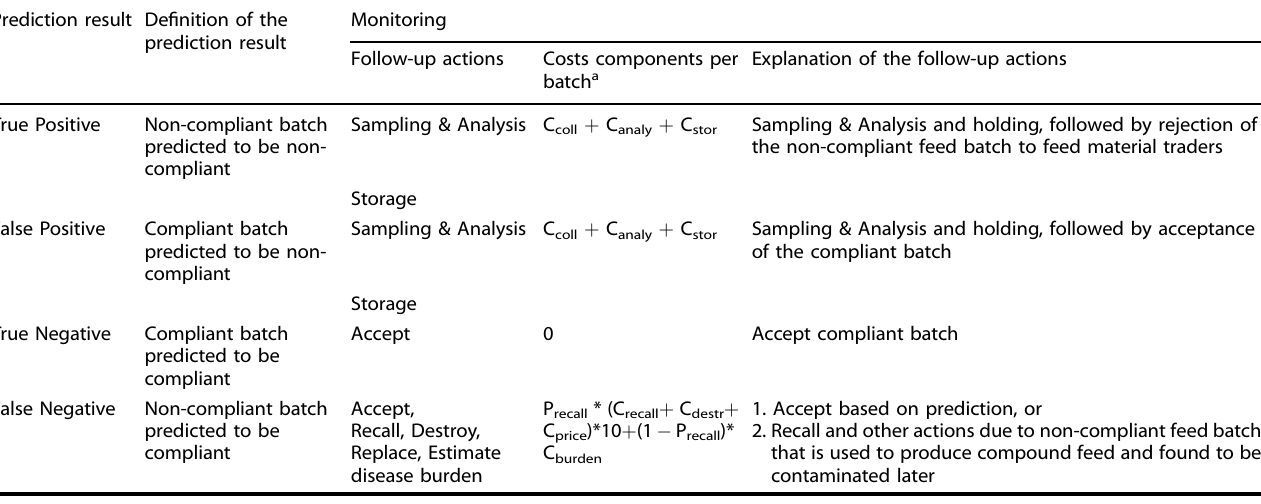
Table 6. Monitoring cost related to the classi fi cation decision of the ML model, and used as one of the criteria for ML selection. Prediction result De fi nition of the prediction